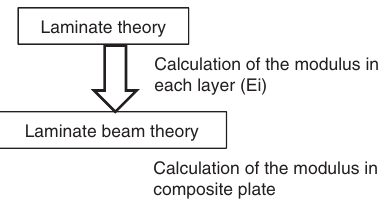
Figure 8 Flowchart of the estimation procedure of bending modulus by the calculation